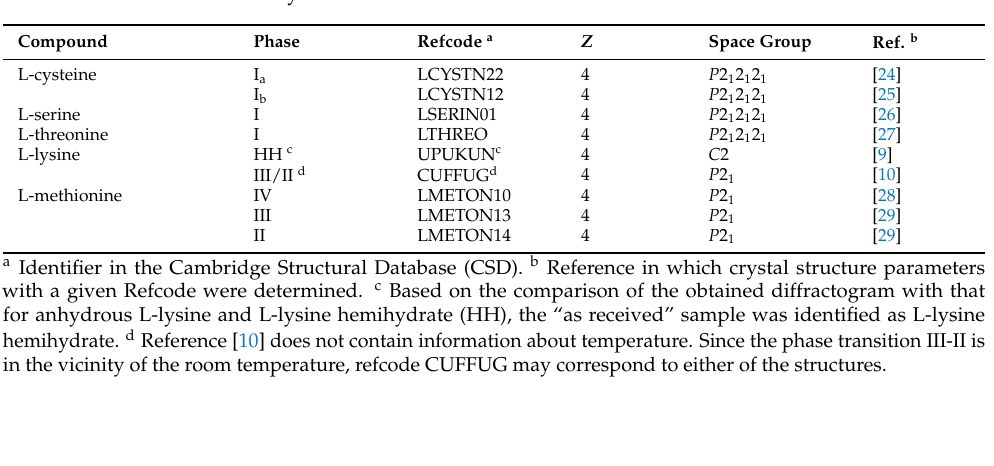
Table 2. Normal-Pressure Crystal Structures of Amino Acids Studied in this